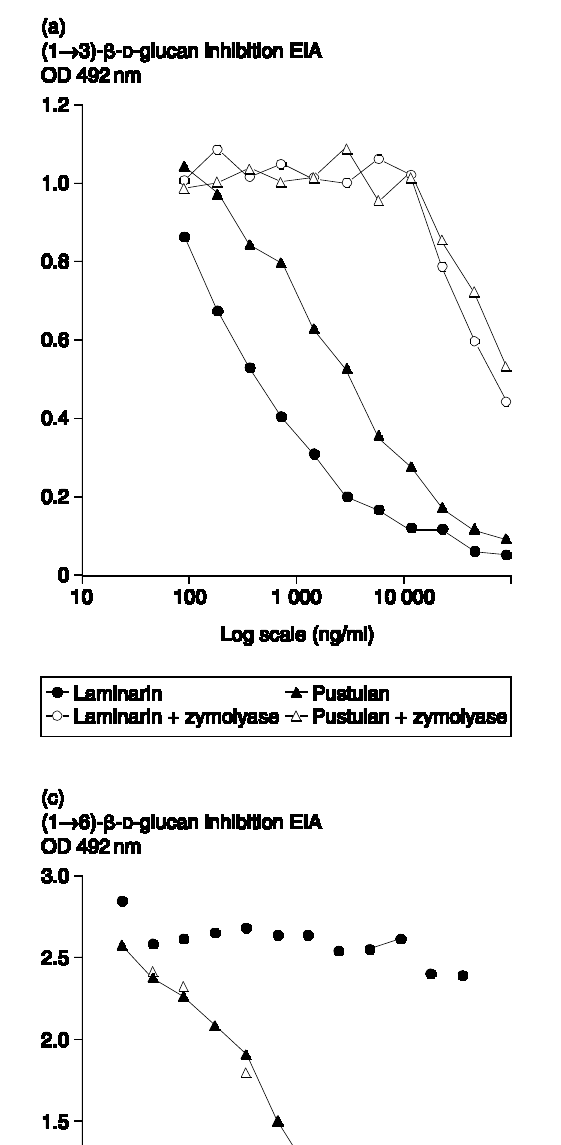
-treated laminarin and pustulan in (b) (1 ® 3)- b - D -glucan EIA 4